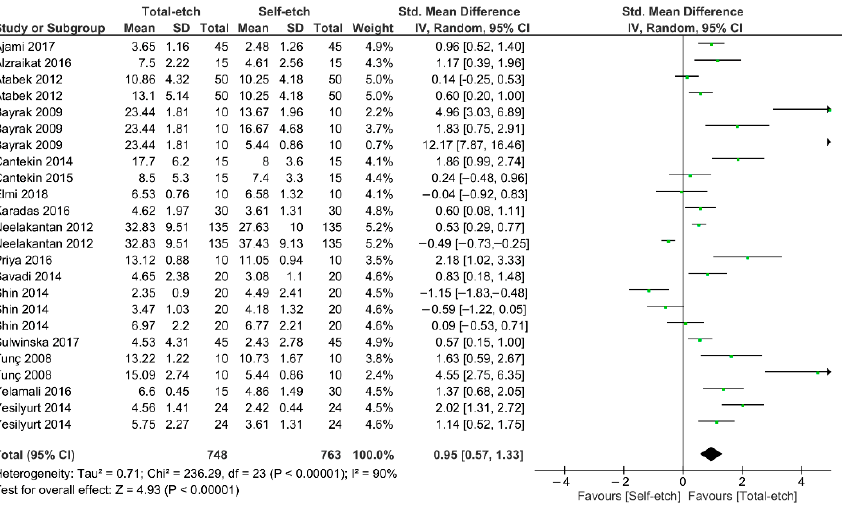
Figure 2. Findings of the meta-analysis of the bond strength of resin-based materials to MTA calcium silicate-based cement. Bond strength was higher when a total-etch adhesive was used ( p < 0.01). Figure 3 shows the meta-analysis of the bond strength values of resin composite materials to Biodentine™ cement. According to the analysis, the bond strength was similar between the total-etch and self-etch adhesives ( p = 0.12). A high heterogenicity